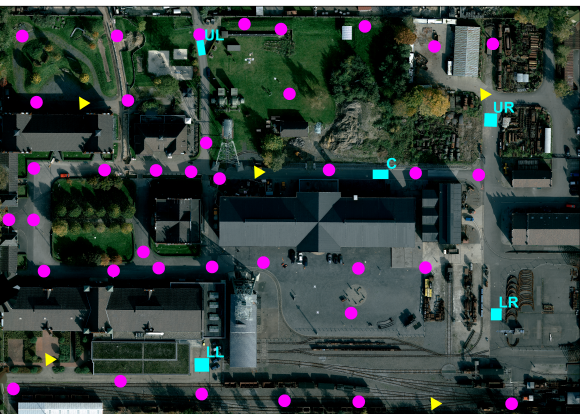
Figure 2. Orthophoto of test field Zeche Zollern with GCP (yellow triangle)/Check point (magenta circle) distribution and areas of surface analysis (cyan